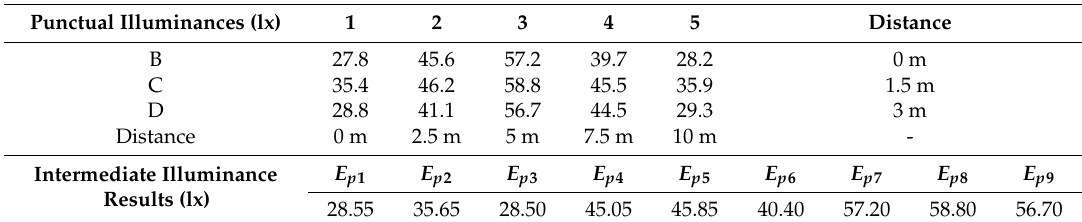
Table 6. Transparent (A) cover field measurements and calculated parameters ( E pi ) used to obtain E m , U m , and U g .